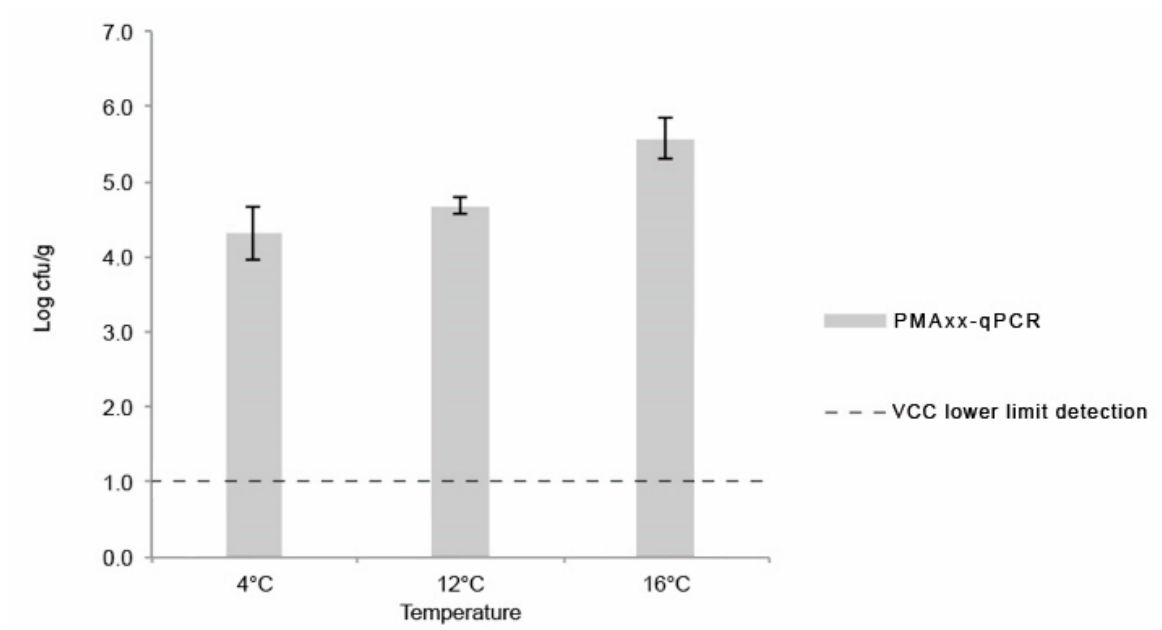
Figure 4. Average and standard-deviation of L. monocytogenes concentration (log cfu/g) obtained by PMAxx-qPCR on the final day of each assay (day 8). The dotted line represents uncertainty of viable cell countings method.